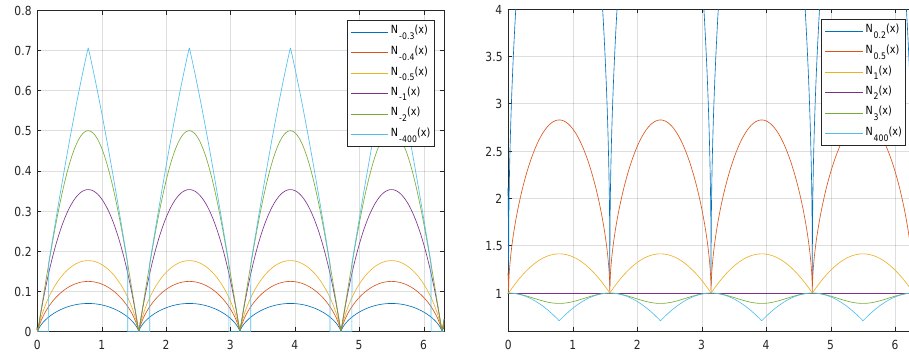
Figure 5. The function N p for several values of p .